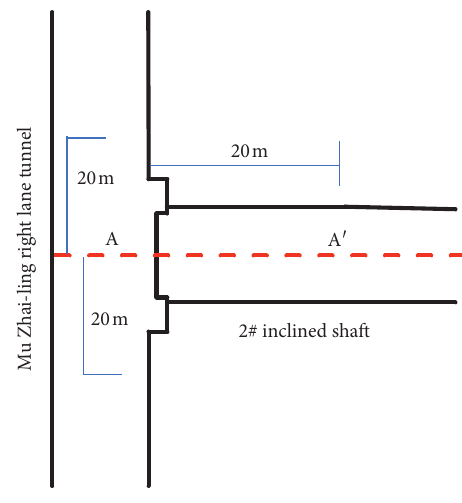
Figure 11: Tunnel intersection plan.